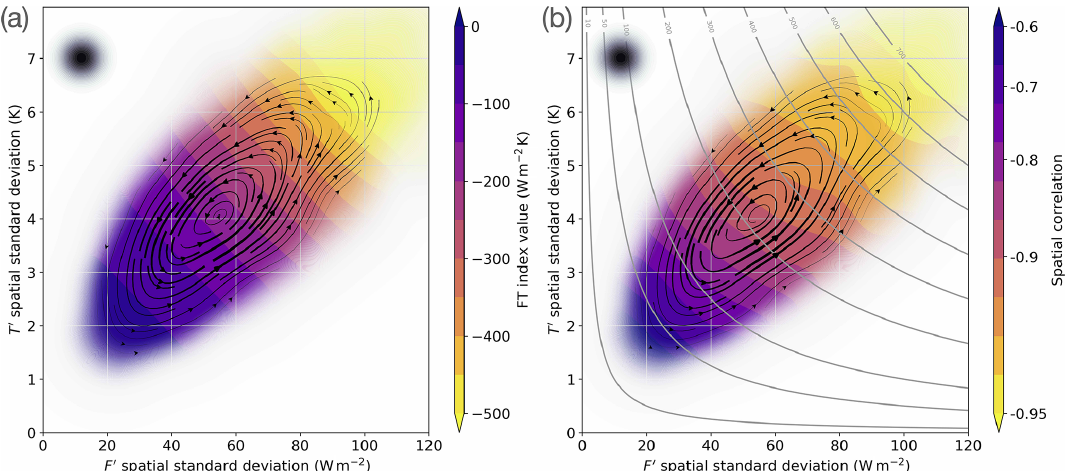
Figure 6. Kernel-averaged circulation in the F (cid:48) – T (cid:48) spatial standard deviations’ phase space. Streamlines correspond with kernel-averaged trajectories traced by the product of spatial standard deviations (line thickness proportional to phase speed, plotted where data density is larger than 10). Shading represents values of the FT index value (a) and FT spatial correlation (b) . Grey contours in (b) , drawn at 10, 50, 100Wm − 2 K and then every 100Wm − 2 K, indicate the product of spatial standard deviations. The size of the averaging Gaussian filter is indicated by the black-shaded dot in the upper-left corner.